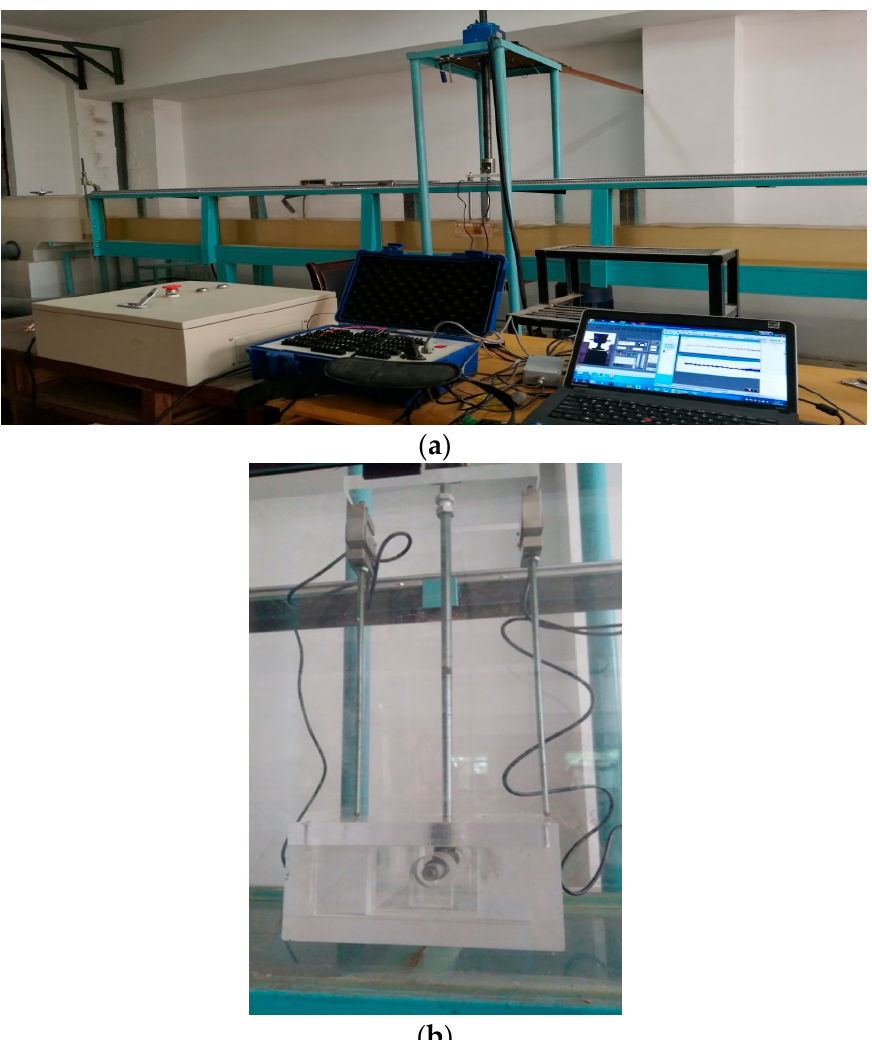
Figure 1. Diagram of the test model: ( a ) Panoramic view of the experimental configuration, ( b ) The diagram of the floating structure.